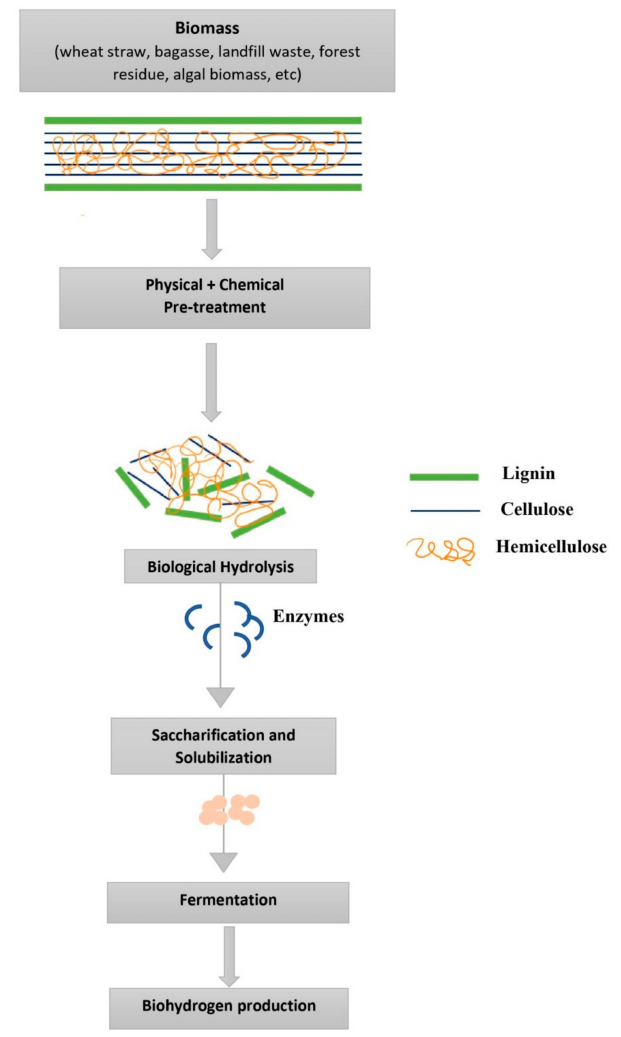
Figure 2. Schematic representation of biomass hydrolysis for biofuel production using physical, chemical, and biological pretreatment methods.